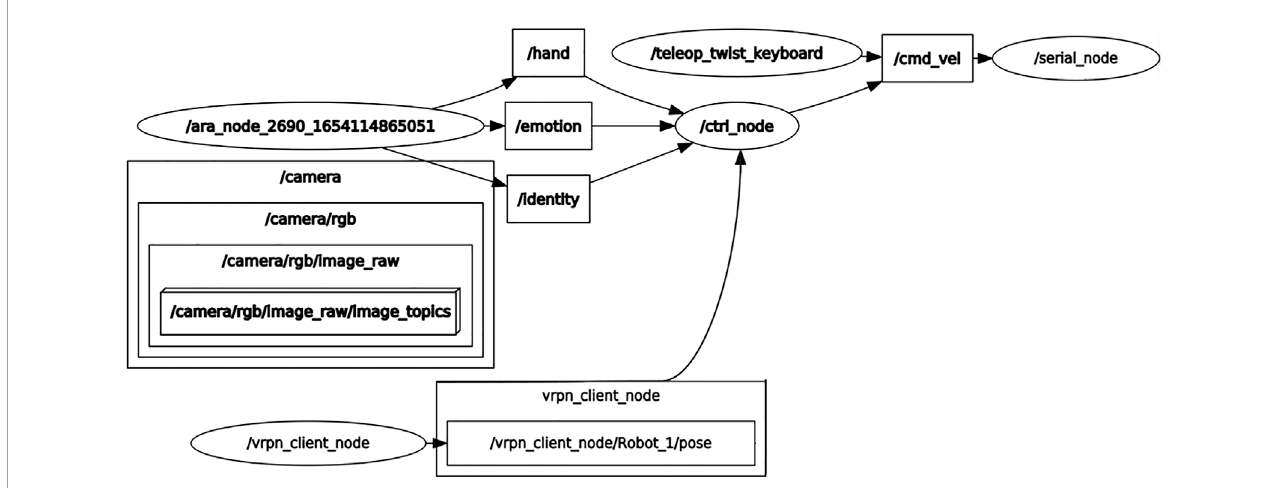
FIGURE 8 Integrated system presented as an ROS graph. This structure shows graphically how the SAR system is integrated. The main nodes ara _ node and ctrl _ node represent the principal energetic consumption elements of the system.